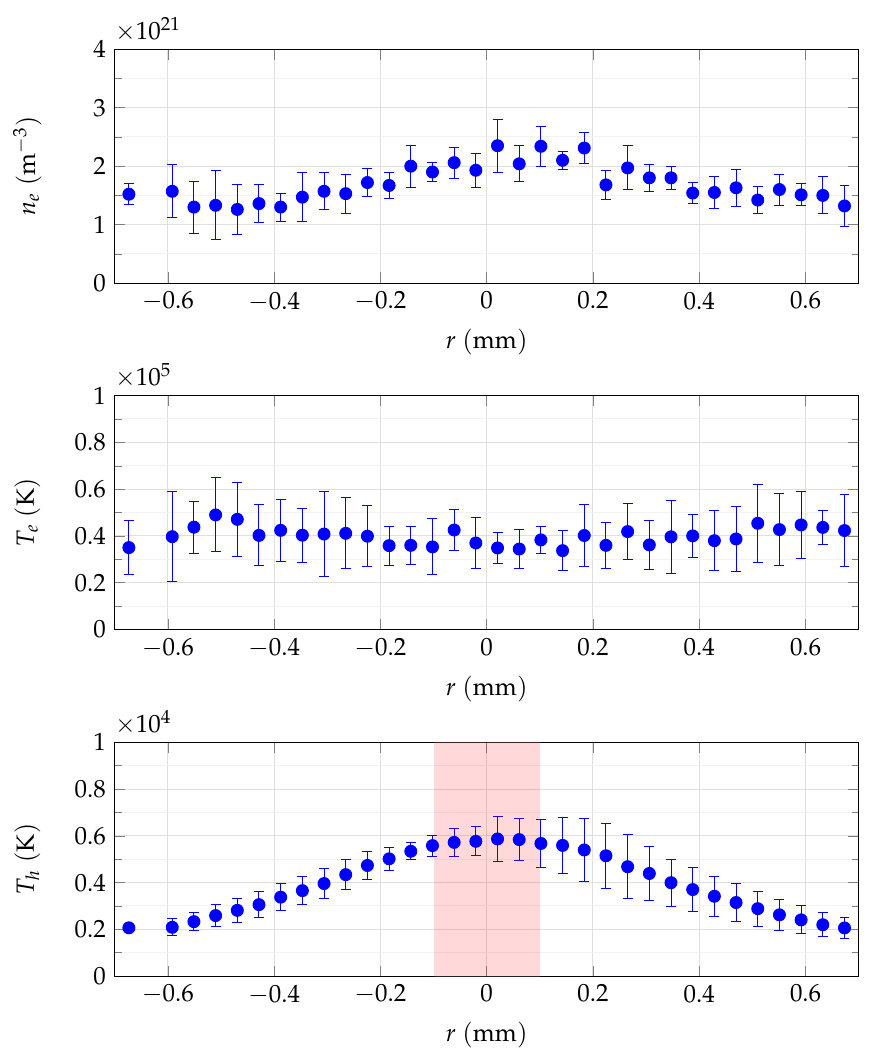
Figure 7. Plasma parameters ( n e , T e , T h ) estimated from scattering measurements at an axial distance of d = 1 mm for a pulse frequency of 60 kHz and a power setting of 100% of the system under study.